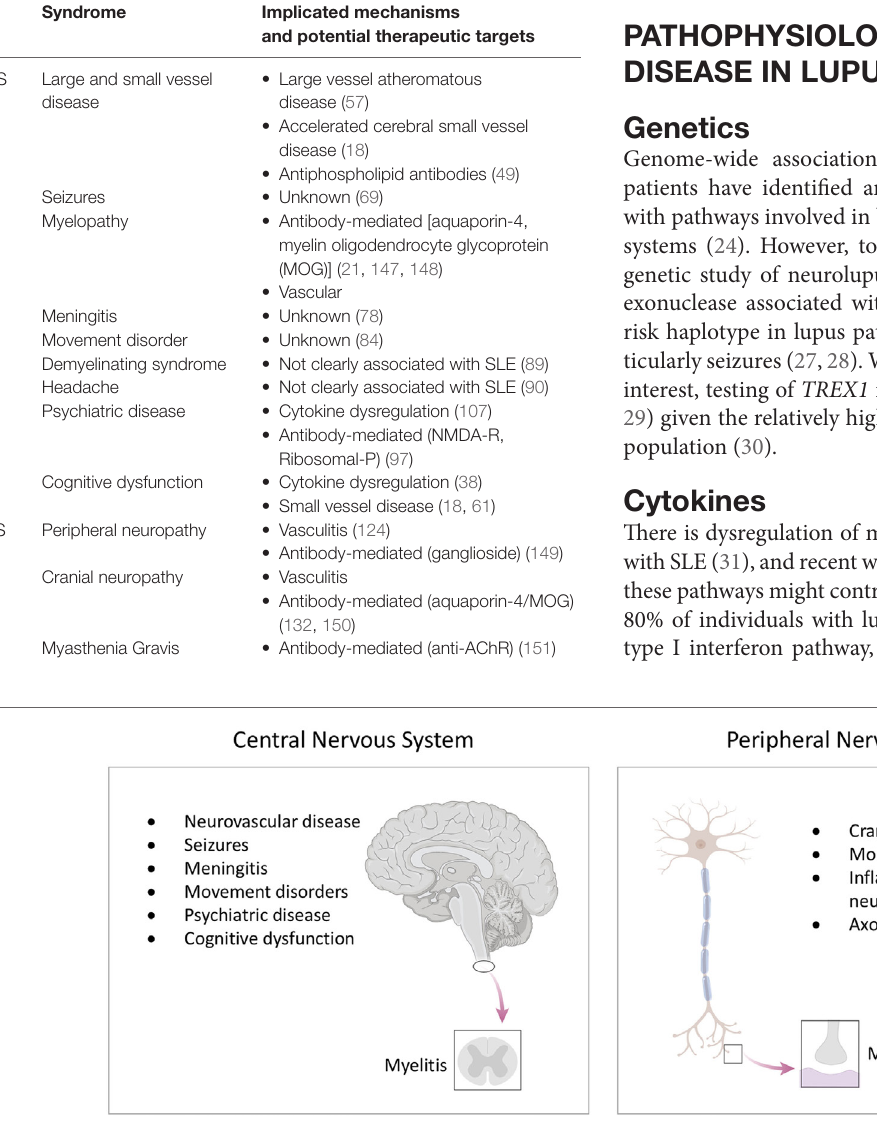
FigURe 1 | The spectrum of neurological disease in lupus. Lupus can affect all levels of the nervous system, including the brain and spinal cord, as well as the peripheral nervous system. See text for detailed descriptions of individual syndromes.